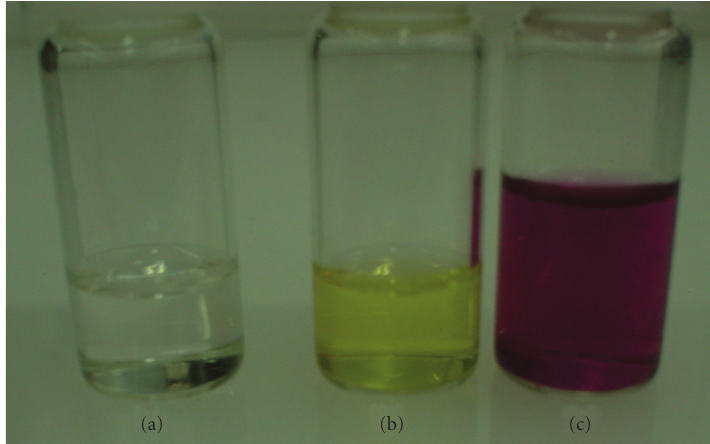
Figure 3: Color change of the tpy-PEG-PLeu solution caused by the complexation with metal ion. (a) Chloroform solution of tpy-PEG- PLeu. (b) Methanol solution of Fe 2+ ion. (c) Mixture of the solution (a) and (b).